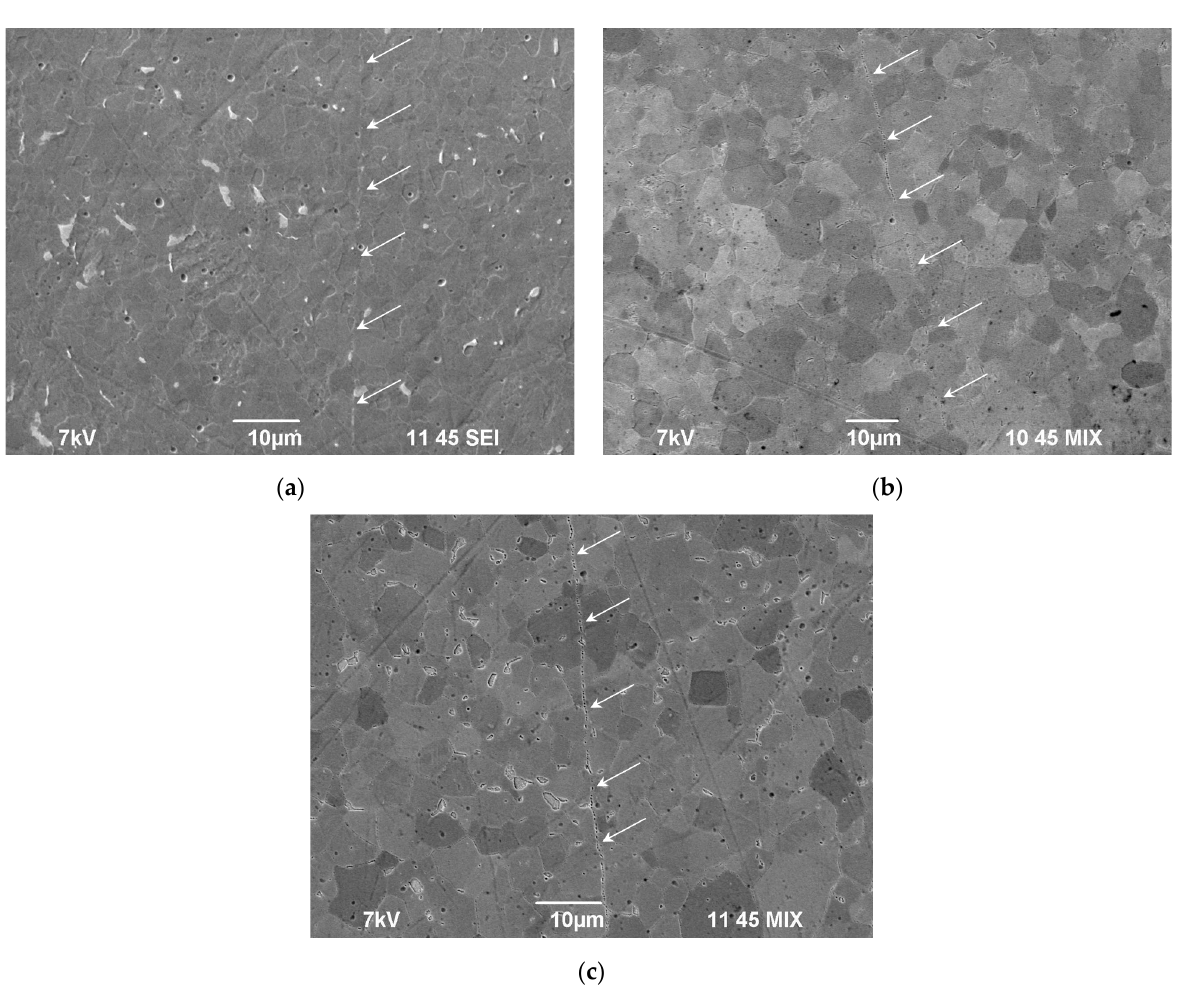
Figure 6. Typical defects in the welded joints of the coarse-grained ( a , c , e ) and UFG ( b , d , f ) alloy after the di ff usion welding (V h = 50 °C/min, T = 800 °C, t = 10 min): ( a , b ) a joint defect, ( c , d ) a macropore, ( e , f ) a micropore. SEM.